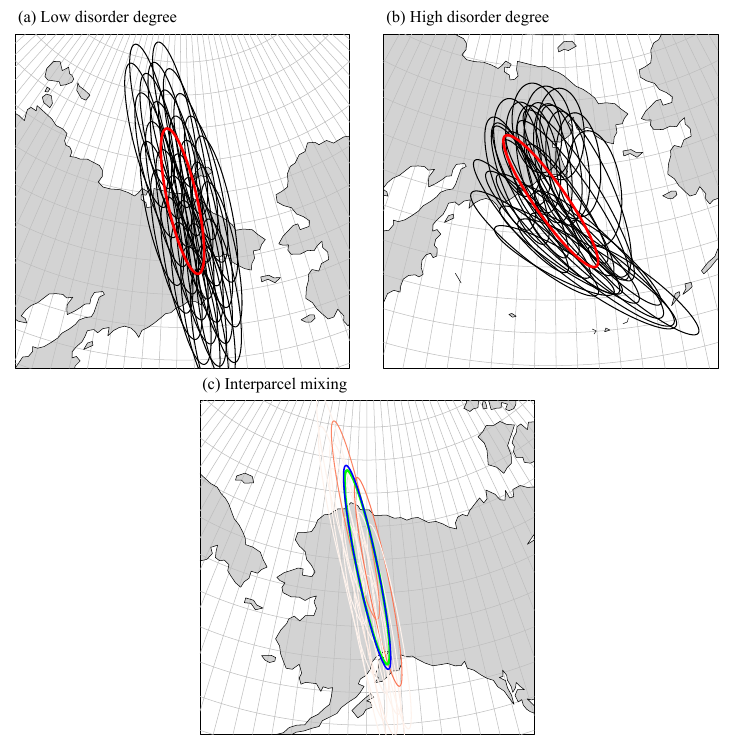
Figure 4. (a) The low-disorder-degree case, where the black ellipses are the surrounding parcels of the red one. (b) The high-disorder-degree case. (c) The blue parcel is mixed with its surrounding parcels, whose colors indicate the mixing weights (the redder, the larger). The blue parcel is shrunk to the green one after